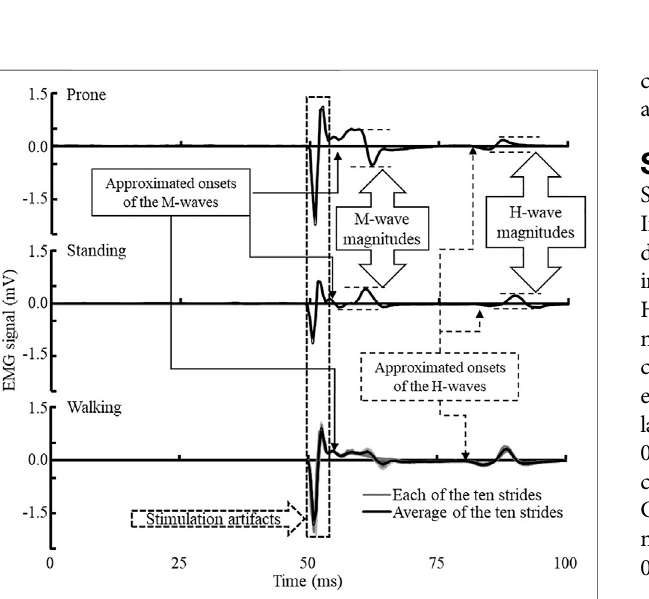
FIGURE 1 | Exemplary H-re fl ex recruitment curves for prone (A) and standing (B) conditions. The magnitudes of the background EMG activities were signi fi cantly less than those of the M-wave so they are not visible in the graphs.